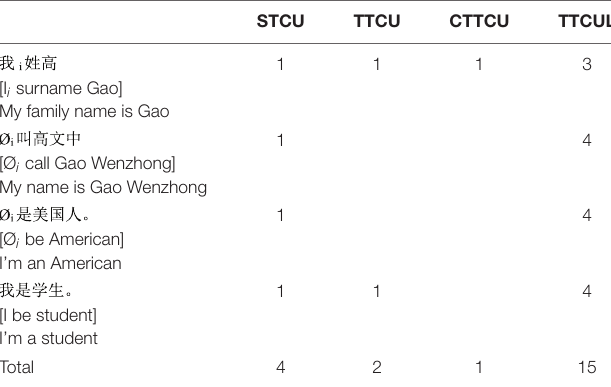
TABLE 1 | A coding sample of free writing task (ID: